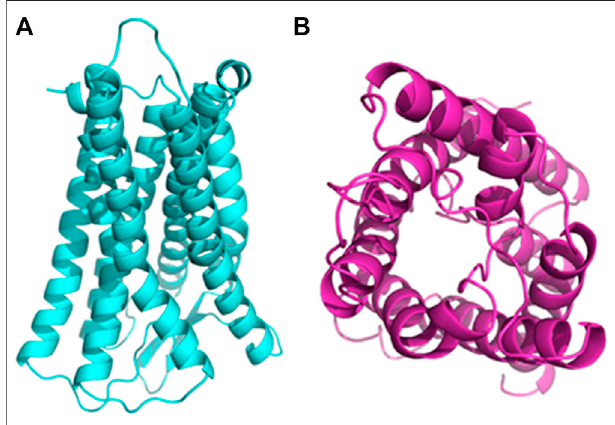
Frontiers in Pharmacology |